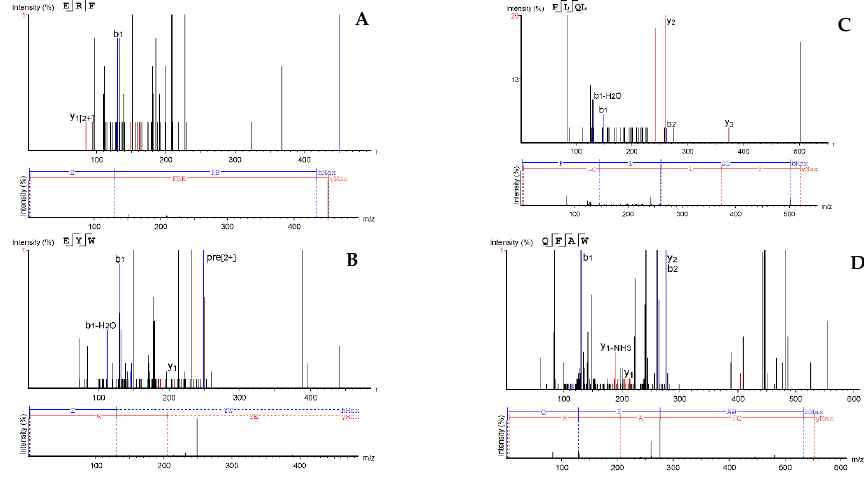
Figure 6. De-convoluted annotated MS/MS fragmentation spectra of peptides in fraction 1C and the corresponding de novo sequencing: ERF ( A ), EYW ( B ), FLQL ( C ), and QFAW ( D ). The ten oligopeptides obtained from fraction 1B are HC, YT, YE, LAN, CTN, LAF, CGN, CSGD, MMGW, and QFAAD while those present in fraction 1C are ERF, EYW,